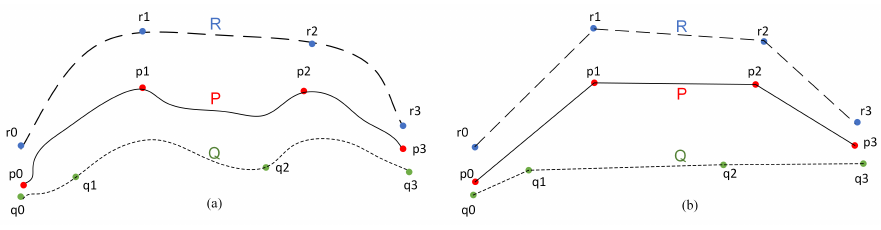
Figure 1. A trajectory similarity distortion